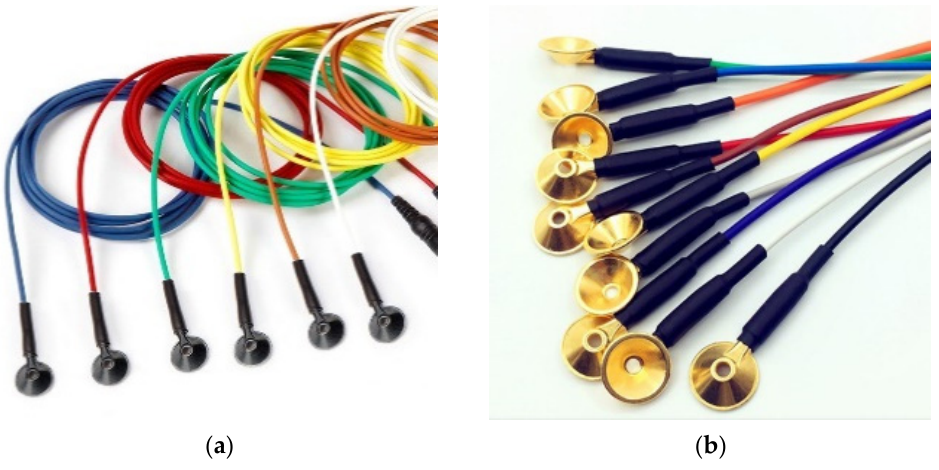
Figure 2. EEG cup wet electrodes: ( a ) Ag/AgCl and ( b ) Au plated.